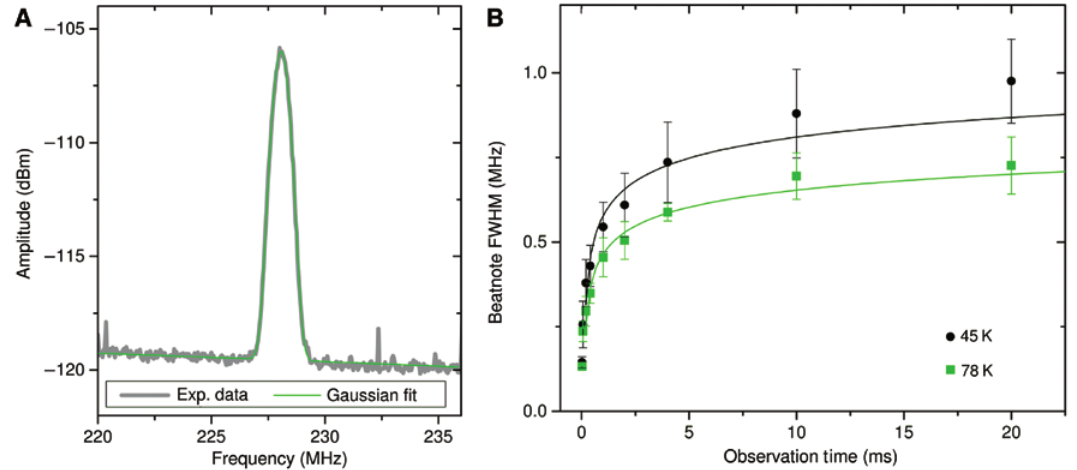
Figure 17: Emission linewidth of a RT THz QCLs based on intra-cavity DFG scheme. (A) Typical beat-note spectrum observed on a spectrum analyzer for 2-ms integration time. (B) Width of the beat note at different time scales measured at two different operating temperatures of the device. The use of an FFT spectrum analyzer allows retrieval of the beat note spectra over different integration times and therefore evaluation of the THz DFG-QCL emission linewidth at different time scales (ranging from 20 μ s to approximately 20 ms). Solid lines are fits using a logarithmic function. Reprinted with permission from [144], copyright